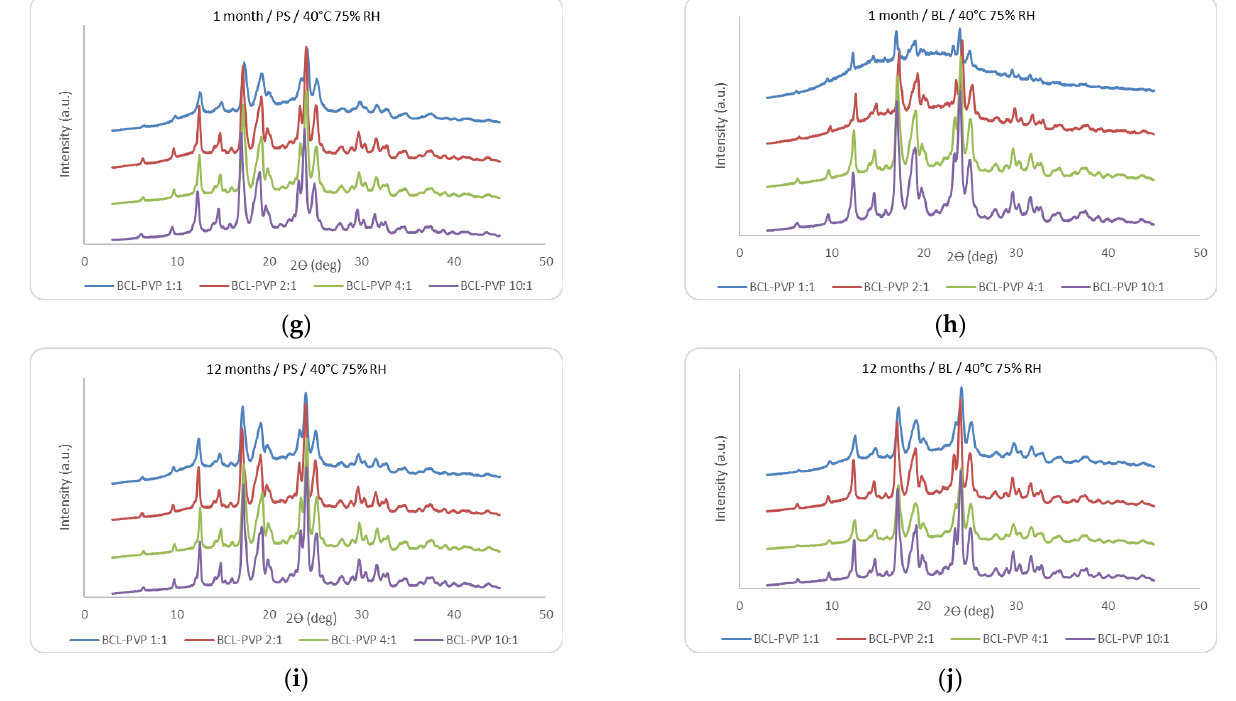
Figure 3. X-ray pattern of bicalutamide from the 1:1, 2:1, 4:1, 10:1 solid dispersions packed into polystyrene containers (PS, left panel) and PVC/Al blisters (BL, right panel)after storage in long-term conditions (25 °C, 60% RH), for 9 months ( a , b ), and 12 months ( c , d ) and accelerated conditions (40 °C, 75% RH) for 2 weeks ( e , f ), 1 month ( g , h ) and 12 months ( i , j ).